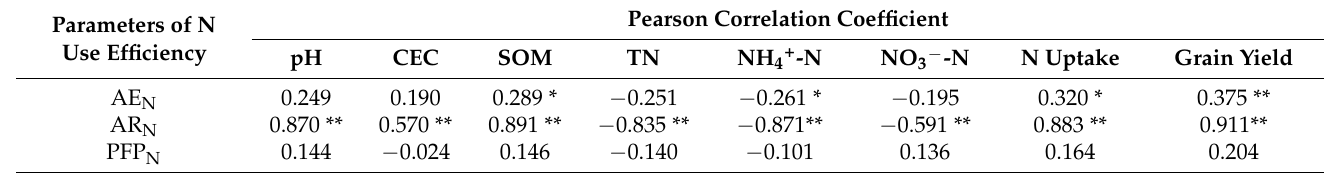
Table 3. Pearson correlation coefficients and partial correlation coefficients between the parameters of N use efficiency and other relevant parameters during the